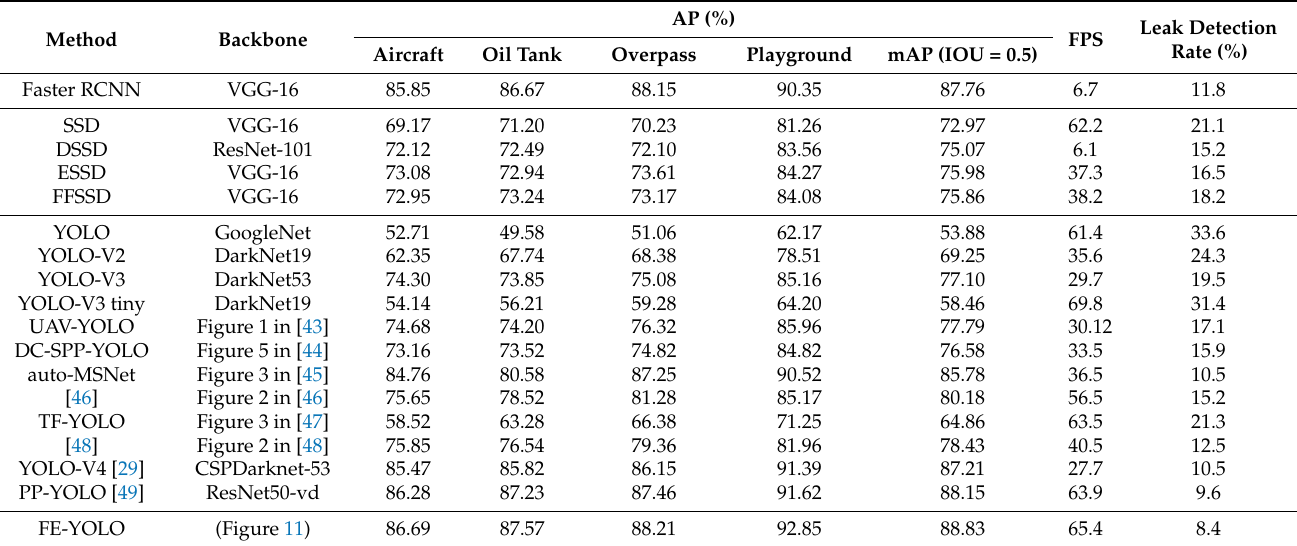
Table 9. The comparative results of different categories in the RSOD dataset.